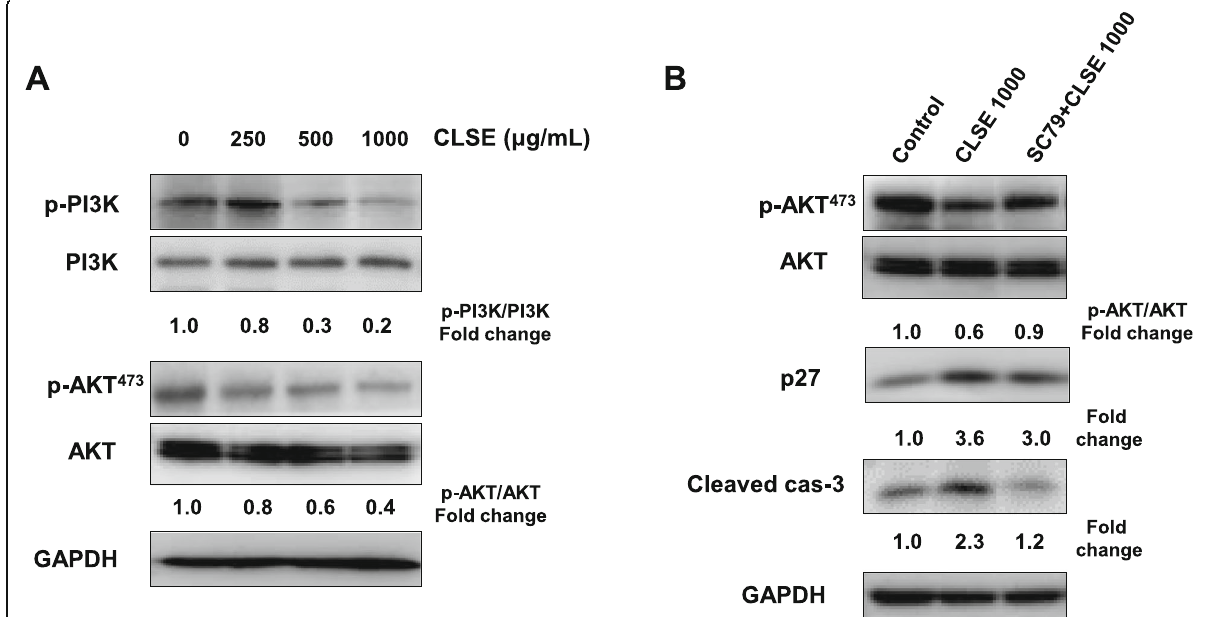
Fig. 5 Effects of Coix lacryma-jobi sprout extract (CLSE) on signaling pathways in HeLa cells. HeLa cells were treated with CLSE (1 – 1000 μ g/mL) ( a ) and/or SC79 (5 μ g/mL) ( b ) for 24 – 72 h, and apoptosis-related proteins (p-PI3K, PI3K, p-AKT, AKT, p27, and cleaved caspase-3) were detected